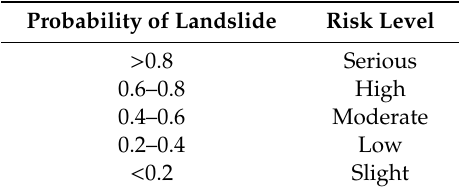
Table 1. Risk classification of landslide